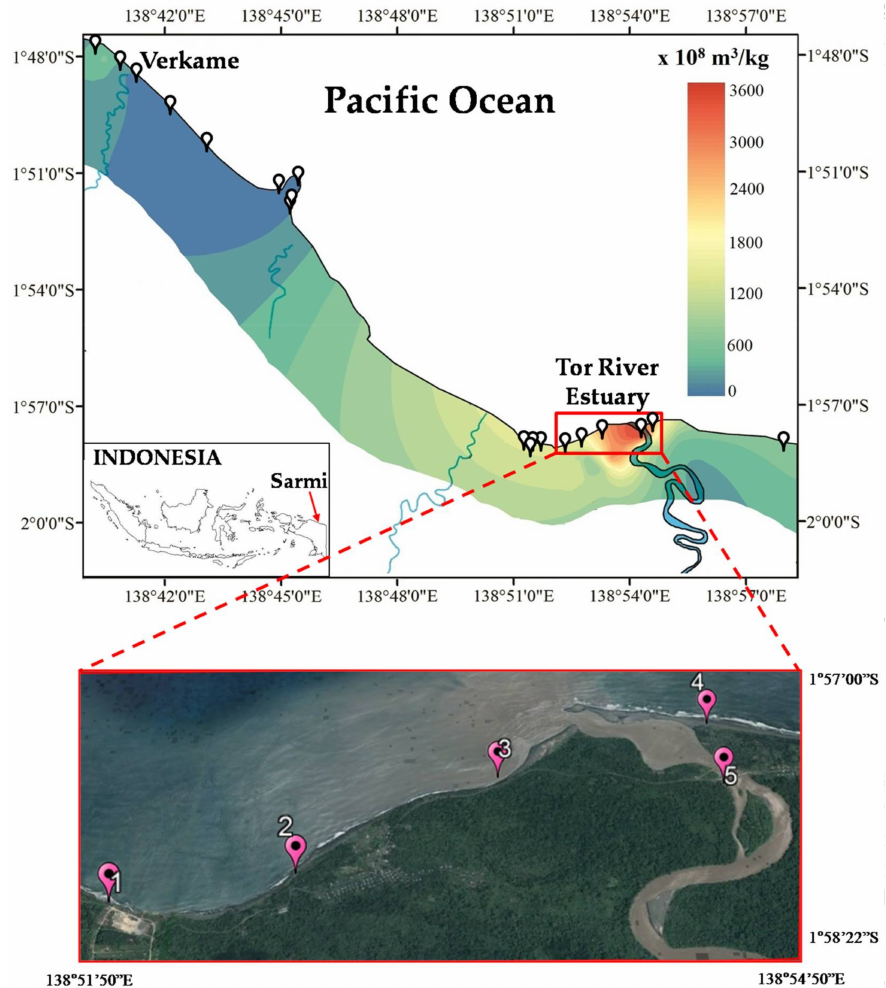
Figure 1. Map of distribution of mass-specific magnetic susceptibility value of iron sand along the Sarmi shoreline. The red box shows the Tor Rover estuary site. The inset shows the map of Indonesia with an arrow showing Sarmi location.